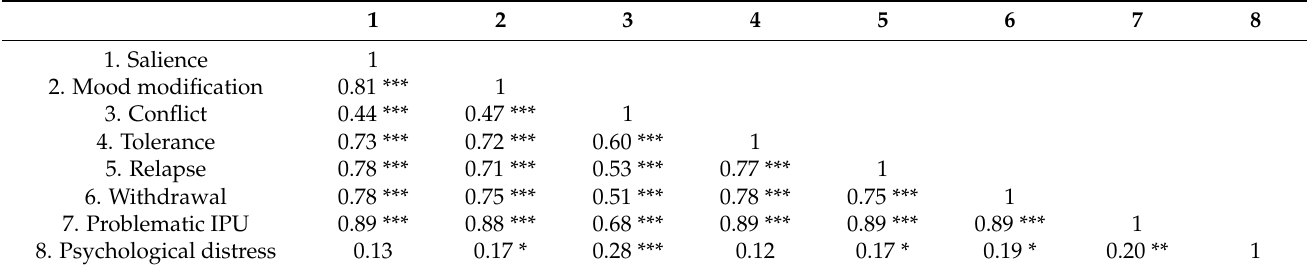
Table 3. Matric correlation between variables ( n =